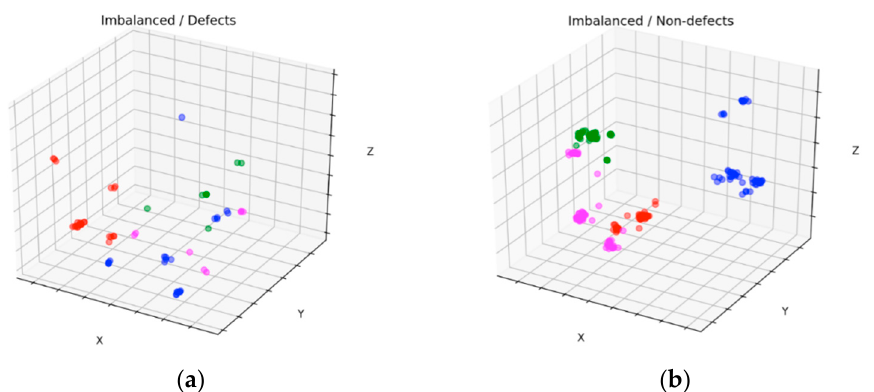
Figure 11. Scatter comparisons of the training data with four clusters for ( a ) defects and ( b ) non- defects in the imbalanced method.